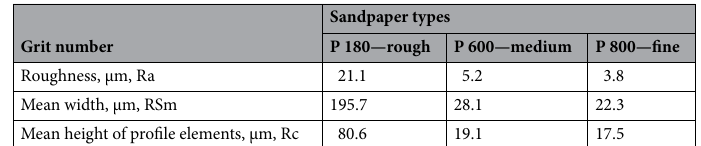
Table 1. Parameters of sandpapers used in feeding experiments (characterized employing Keyence VR 3100).